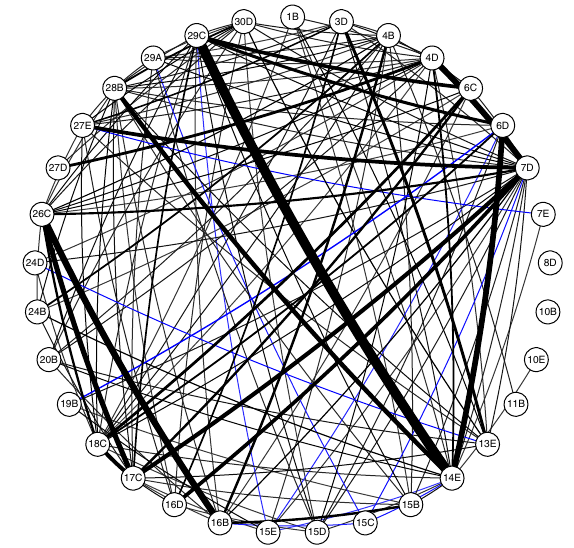
FIG. 4. The network structure of factor 2 items is plotted in a circular distribution. The clockwise ordering of items represents their natural order in the inventory. The stronger the correlation the thicker the connecting line, while the colors black and blue express positive and negative correlations, respectively. For sake of transparency connections with absolute value less than 0.35 are omitted. Item 7D seems to be the central item as it is connected to several other items. Some items, e.g., 8D, seem to hang alone meaning that their connection to factor 2 is quite weak.